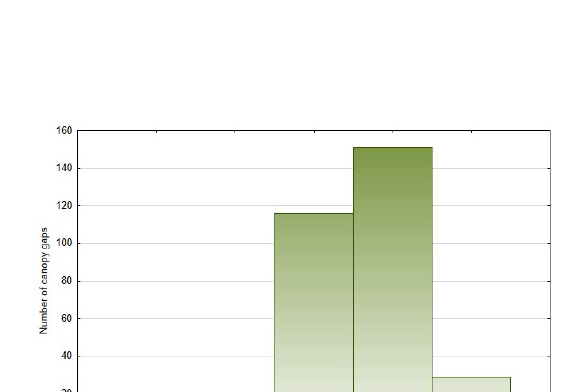
Figure 2. Canopy gap area ( a ), expanded gap area ( b ), canopy gap perimeter ( c ) and expanded gap perimeter ( d ) on aspect categories.